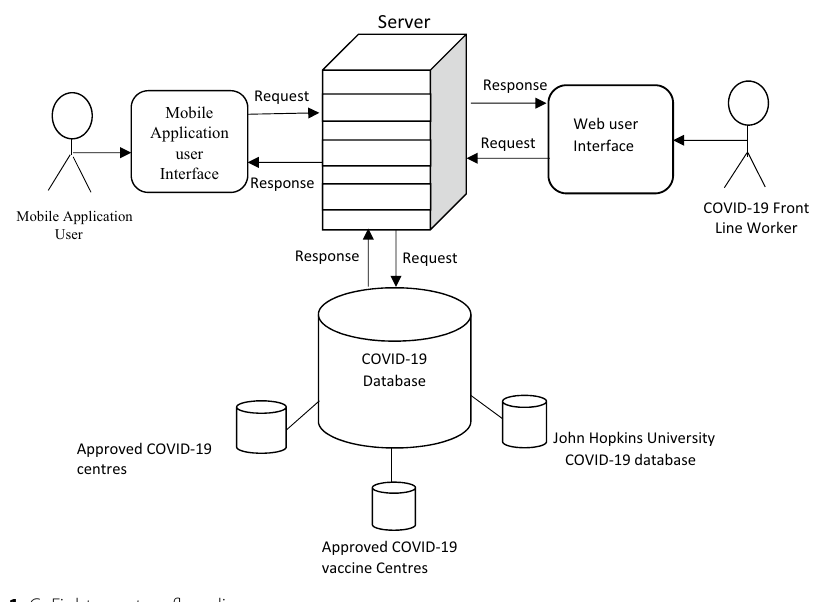
Fig. 1 CoFighter system flow